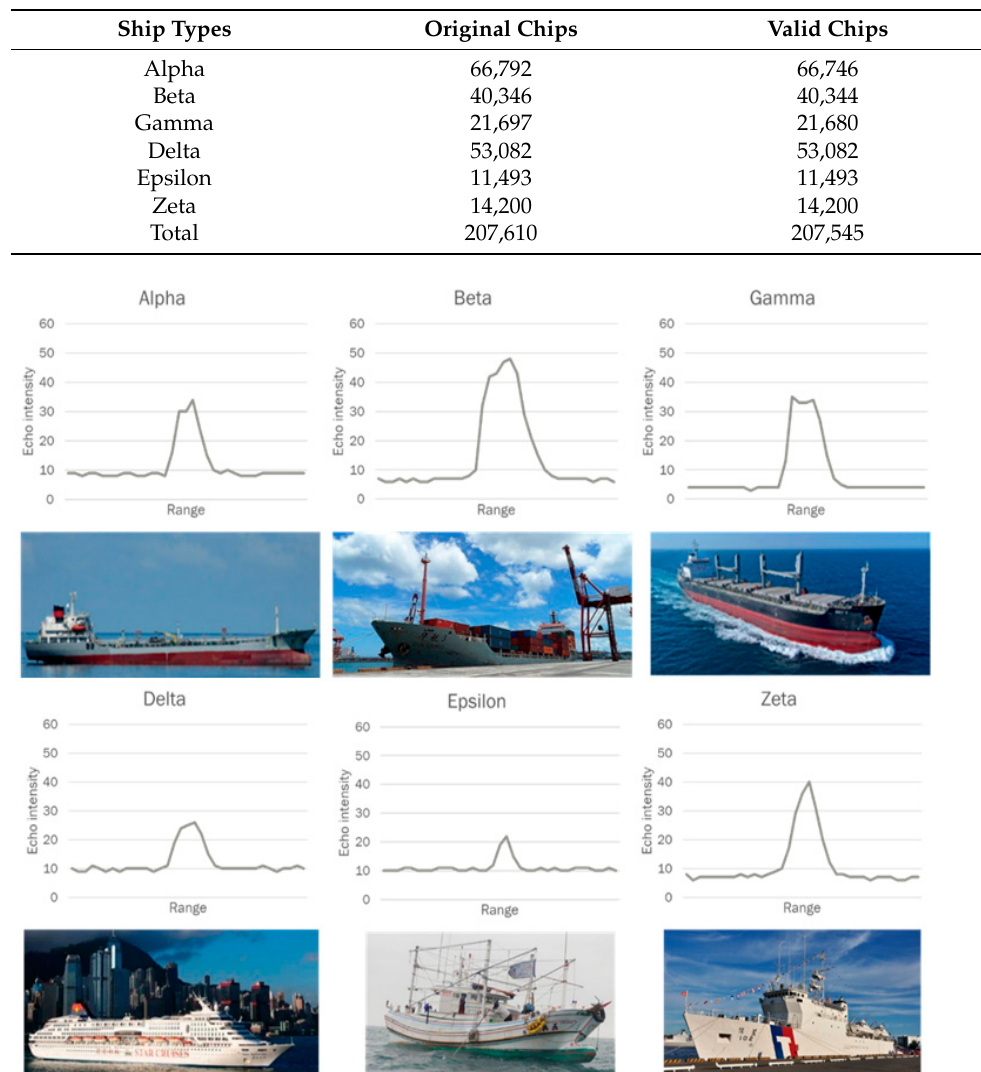
Table 1. Ship types and data chips distribution.